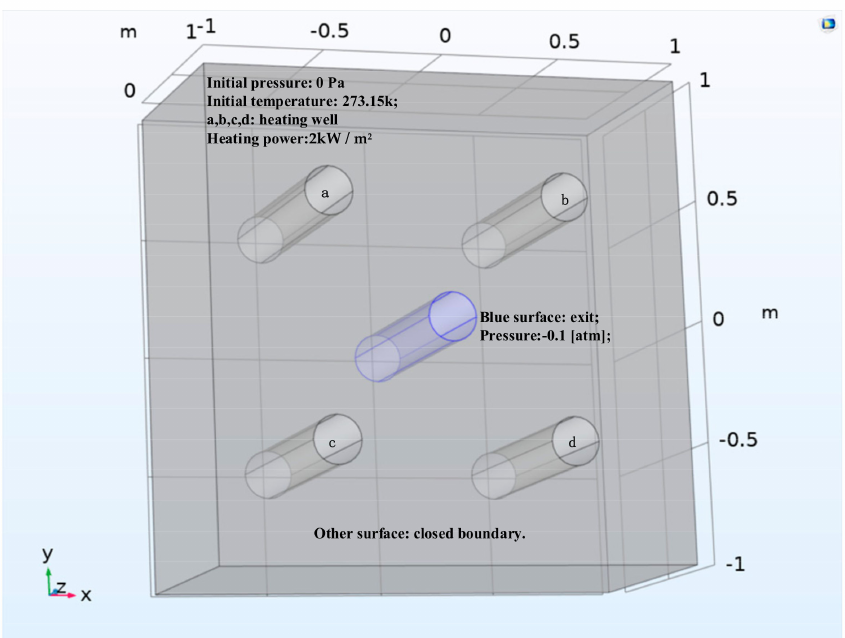
Figure 3. Simulation model of Darcy’s law. As showed in the figure, it is still assumed that the upper boundary of the model is the ground, the main material medium is soil, and the fluid medium in the porous medium is ethylbenzene(liquid). The properties are shown in Table 1. There is no fluid flow and heat exchange on the closed boundary. The four planes on the outside parallel to the axis of the heating well are periodic boundaries.